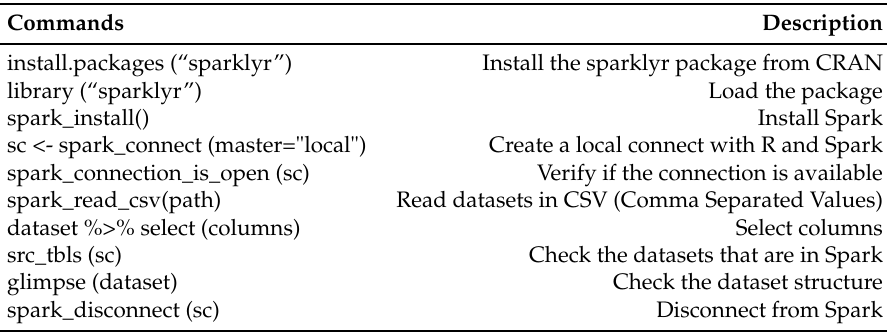
Table 1. Basic commands in the sparklyr package.